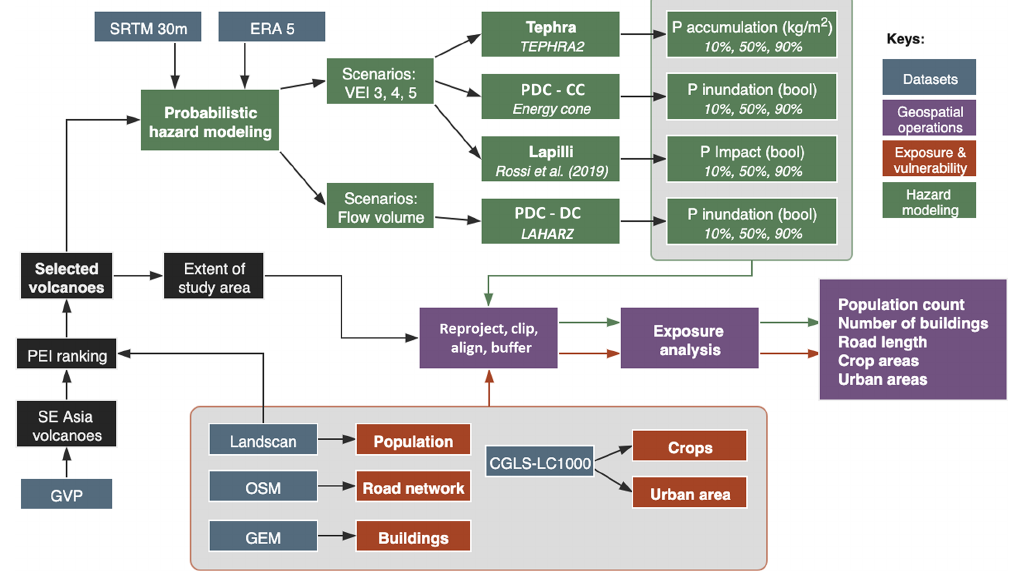
Figure 2. Schematic outline of the study’s methodology for exposure analysis. CGLS-LC: Copernicus Global Land Service-Land Cover; ERA 5: Reanalysis dataset from the European Centre for Medium-Range Weather Forecasts (ECMWF); GEM: Global Earthquake Model; GVP: Global Volcanism Program of the Smithsonian Institute; OSM: OpenStreetMap; PEI: Population Exposure Index; SRTM: Shuttle Radar Topography Mission; bool: Boolean workflow was made using